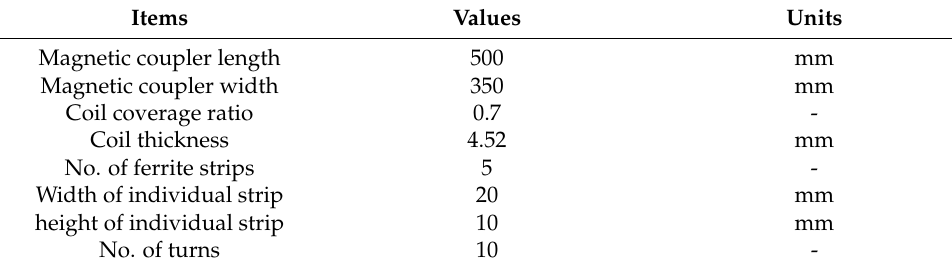
Table 6. Mechanical design of the magnetic